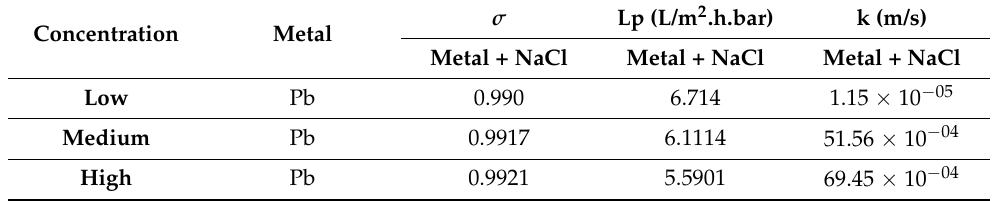
Table 4. Calculation of non-linear parameters of the model by concentrations for the Pb. Concentration